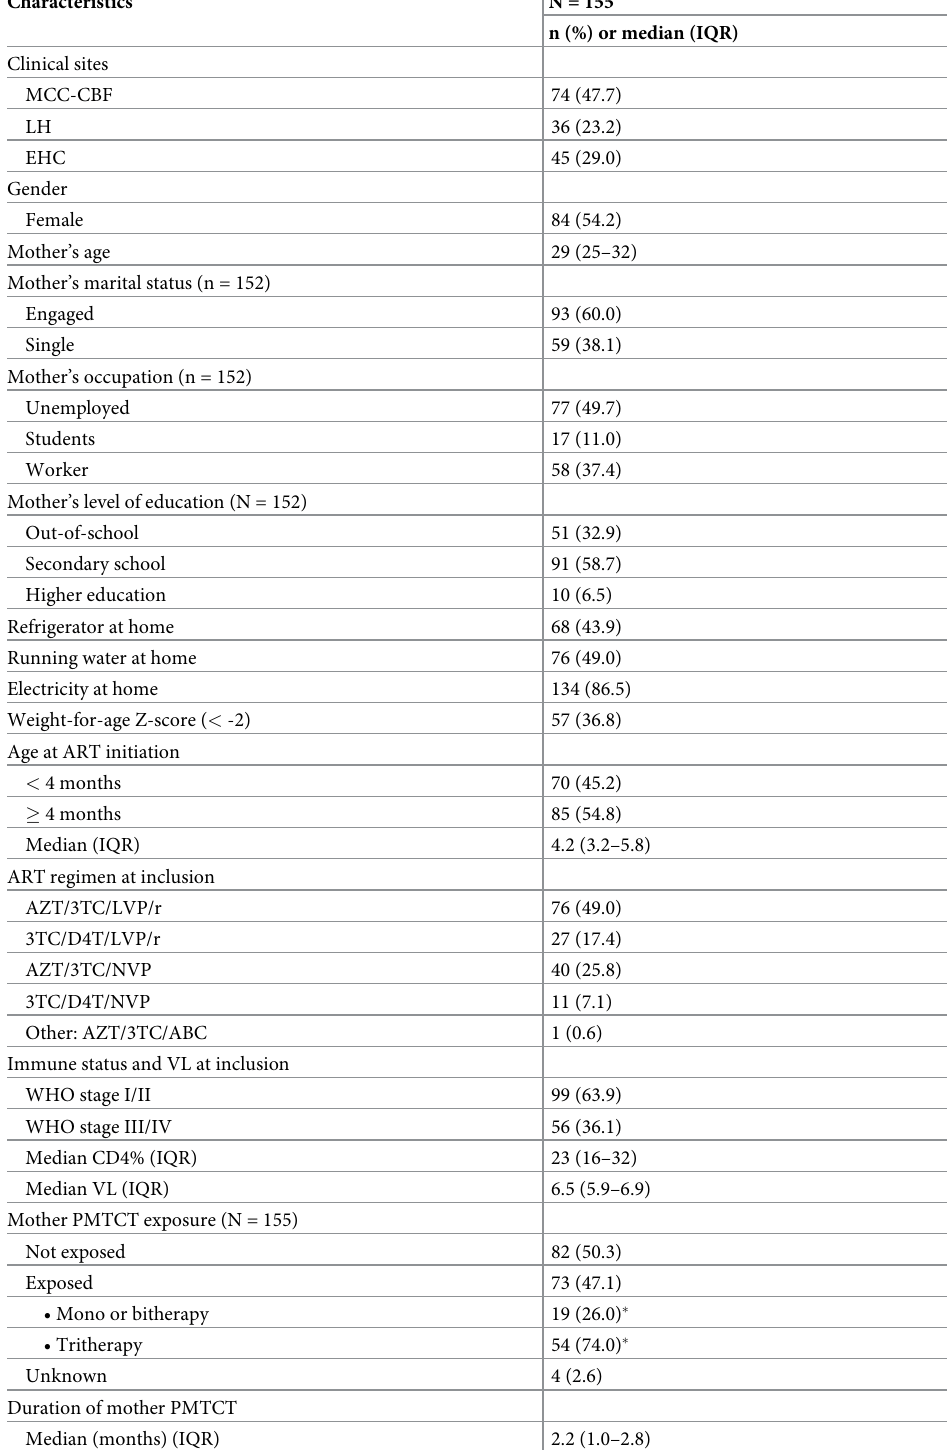
Table 1. Baseline characteristics of HIV-infected children and family at enrolment, ANRS-Pediacam cohort,